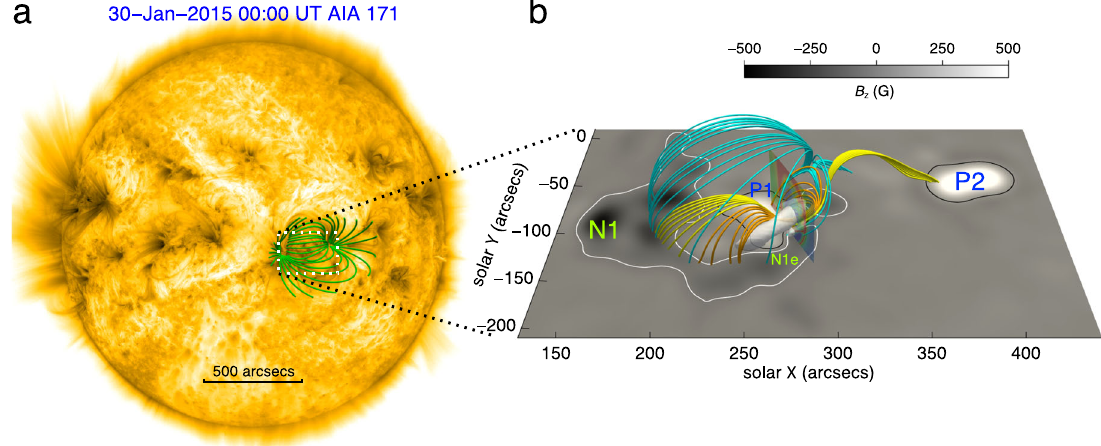
Fig. 2 Overview of the M2.0 class solar fl are observed on 30 January 2015. a Full-disk image of AIA 171 Å at 00:00 UT on January 30. Some selected fi eld lines (in green) at a relatively high altitude are overlaid in the active region. b The initial reconstructed magnetic fi eld with a zoomed-in view of the region corresponding to the white dotted box in panel a . Yellow and orange lines represent the bifurcated and unbranched parts of the MFR, respectively. Cyan lines represent the dome-like structure. The white semi-transparent isosurface represents the electric current density that is larger than 32.9% of the maximum value in the whole domain. The transparent slice perpendicular to the MFR axis shows a cross section of the MFR delineated by the QSLs. The background image shows the magnetogram with polarities labeled as N1, N1e, P1, and P2, overlaid by the white and black contours with contour levels of B z ( B z ≡ e z ⋅ B ) being − 50 G and 50 G, respectively.